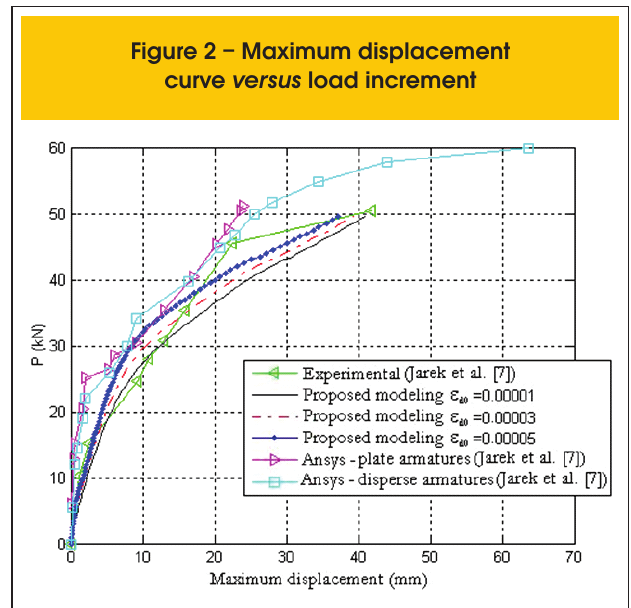
Figure 2 – Maximum displacement curve versus load